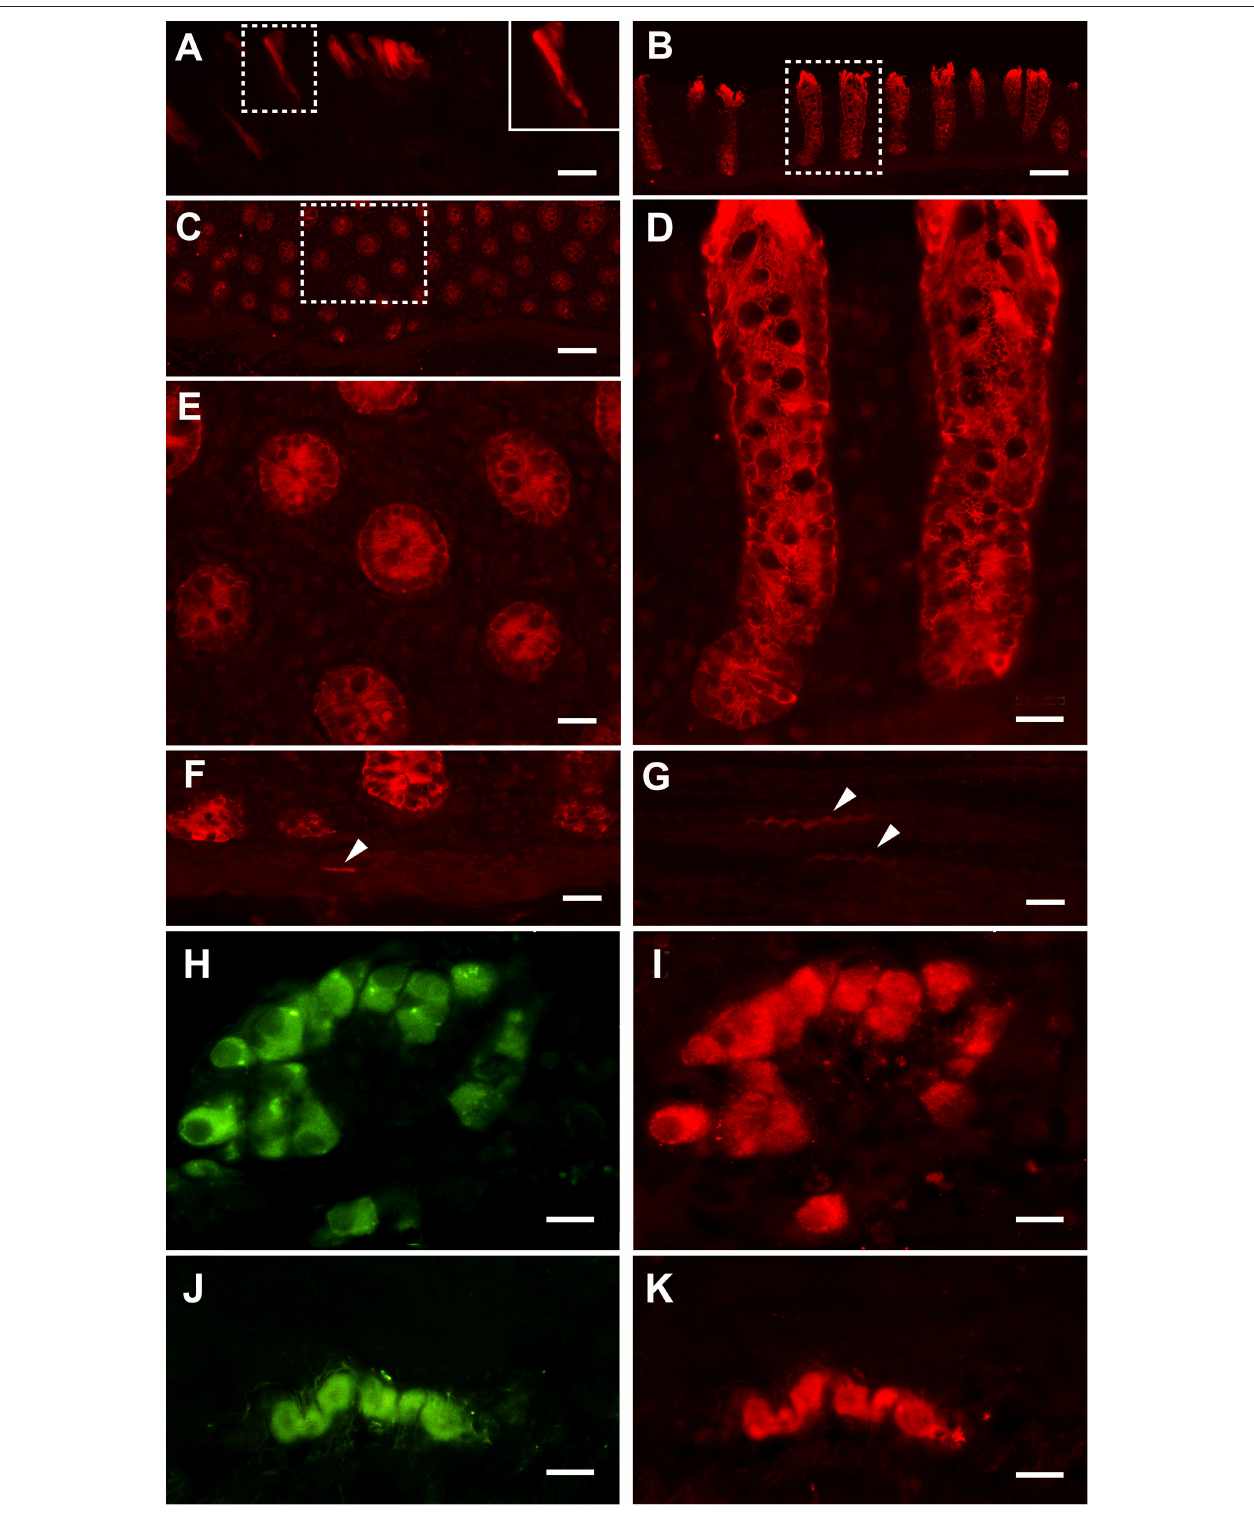
FIGURE 2 | Proteinase-activated receptor 2 immunostaining (PAR 2 -IR) in the large colon. Note the strong immunoreactivity in the enterocytes (A) . Inset in (A) : high magnification of the boxed area. Strong immunoreactivity for the PAR 2 is located in the intestinal glands ( B : longitudinal section; C : transverse section). (D) High-magnification view of the boxed in area (B) . (E) High-magnification view of the boxed in area (C) . Smooth muscle cells (arrowheads) distributed in the muscolaris mucosae (F) and the muscular layer (G) occasionally show weak immunoreactivity. In the submucosal (H,I) and myenteric (J,K) plexi, neurons immunoreactive for the HuC/D (in green: H,J ) are immunoreactive for PAR 2 (in red: I,K ). Scale bars: (A,D,E,F,G) = 25 µ m; (B,C) = 100 µ m; (H–K) = 25 µ m (scale bar for insets = 10 µ m).